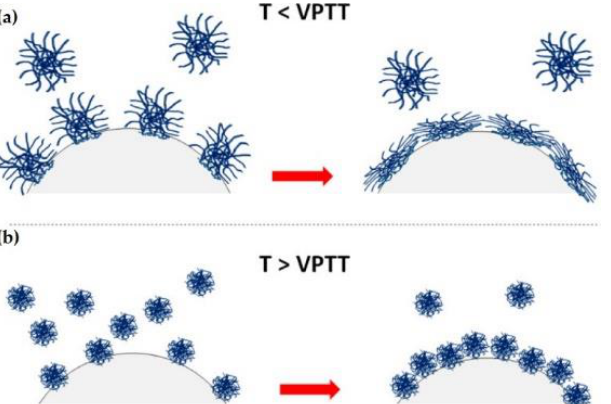
Figure 2. Sketch of the conformation of microgels adsorbed at a fluid interface from temperatures below ( a ) and above ( b ) the phase volume transition (VPTT: volume phase transition temperature). Adapted from Wu et al. [52] with permission from the American Chemical Society, Copyright (2019).